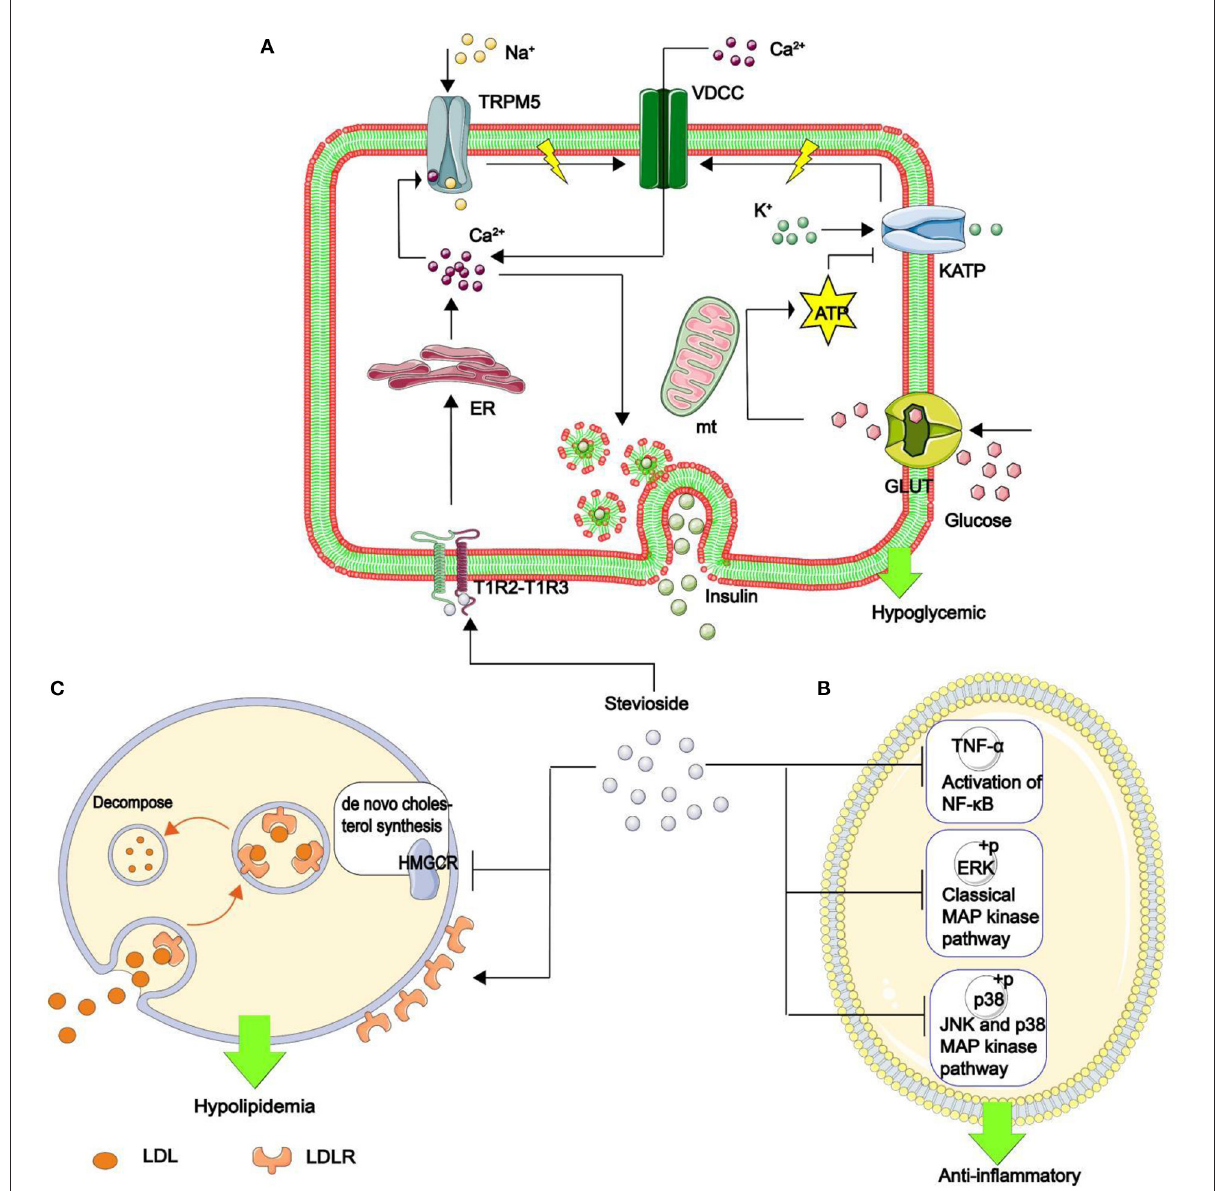
FIGURE10 The mechanism of stevia glycoside in hypoglycemic, anti-inflammatory, and hypolipidemic. (A) Stevia glycoside binds to sweet receptors (T1R2–T1R3 dimer), prompting the endoplasmic reticulum to release Ca 2 + . Ca 2 + opens the transient receptor potential ion channel protein 5 (TRPM5), allowing Na + to enter and generate action potentials. At the same time, glucose is transferred to the mitochondria by enhanced diffusion of glucose transporter to generate ATP, which inhibits the opening of the ATP-sensitive potassium (KATP) and increases action potential production. Finally, the action potential opens the voltage-dependent calcium channel (VDCC), which allows Ca 2 + to flow in. Thus, an increase in Ca 2 + in β cells stimulates insulin secretion and hypoglycemia. (B) Stevia glycoside reduces the inflammatory factors IL-1 β And IL-6 production, as well as the phosphorylation of two critical MAPK pathway proteins, p38 and ERK, as well as decreased TNF- α expression and hence NF- κ B activation, all of which contribute to inflammation resistance. (C) Stevia glycoside decreases intracellular cholesterol by inhibiting HMGCR expression, the rate-limiting enzyme in the de novo cholesterol synthesis pathway, while increasing the cell surface LDL binding receptor (LDLR), promoting cholesterol breakdown in the cell, and the LDLR returns to the cell surface, resulting in hypolipidemia.